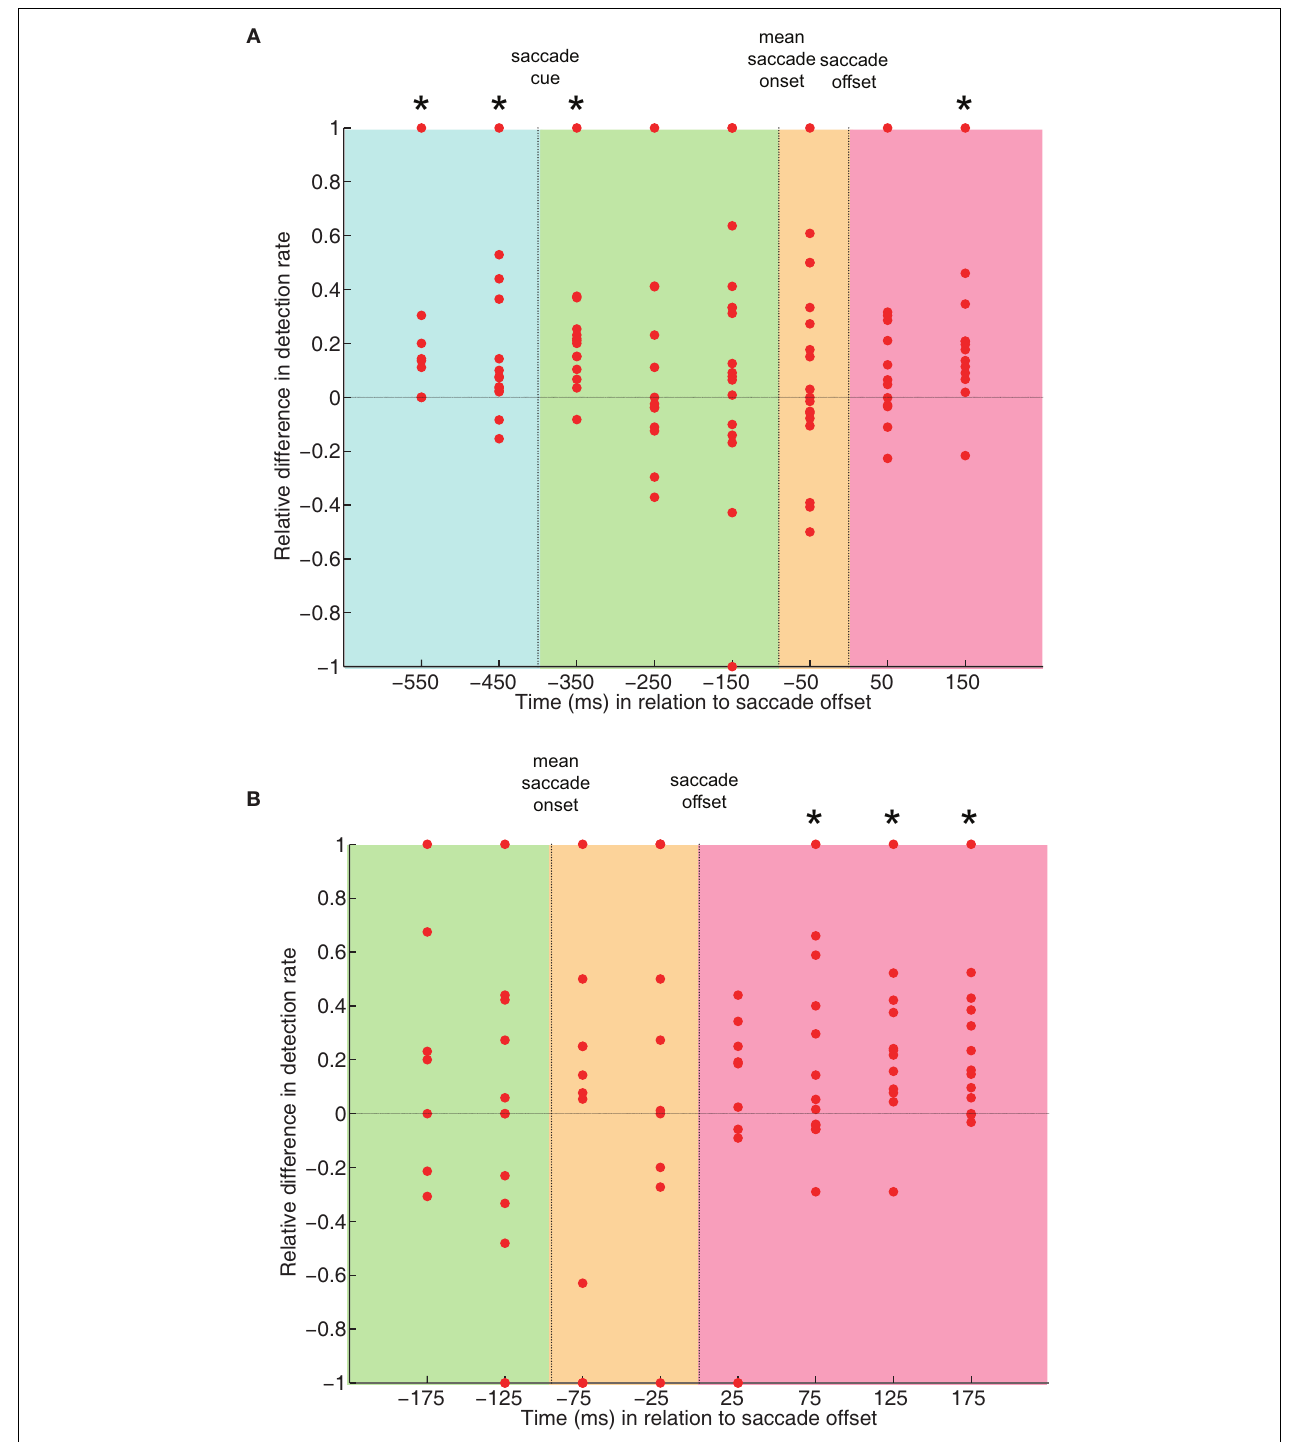
out-of-time targets in that particular subject.Vice versa for negative differences. Note that data points for several subjects may overlap and that the number of data entries varied across individual bins (see Results). As in Figures 3C,D , bins always included data centered around the time point labeled on the x